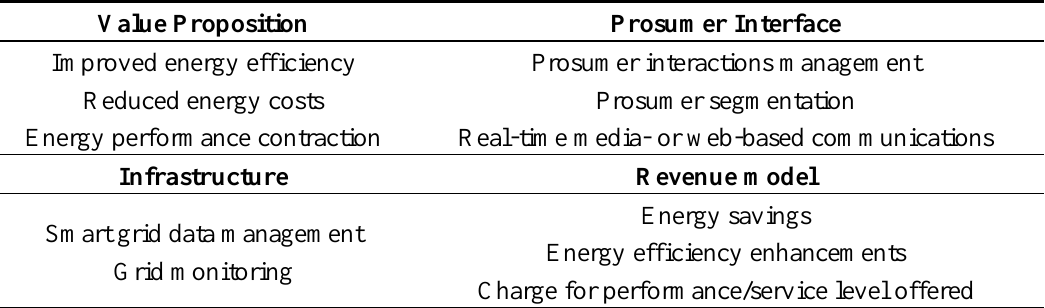
Table 4. ESCO prosumer-oriented business model